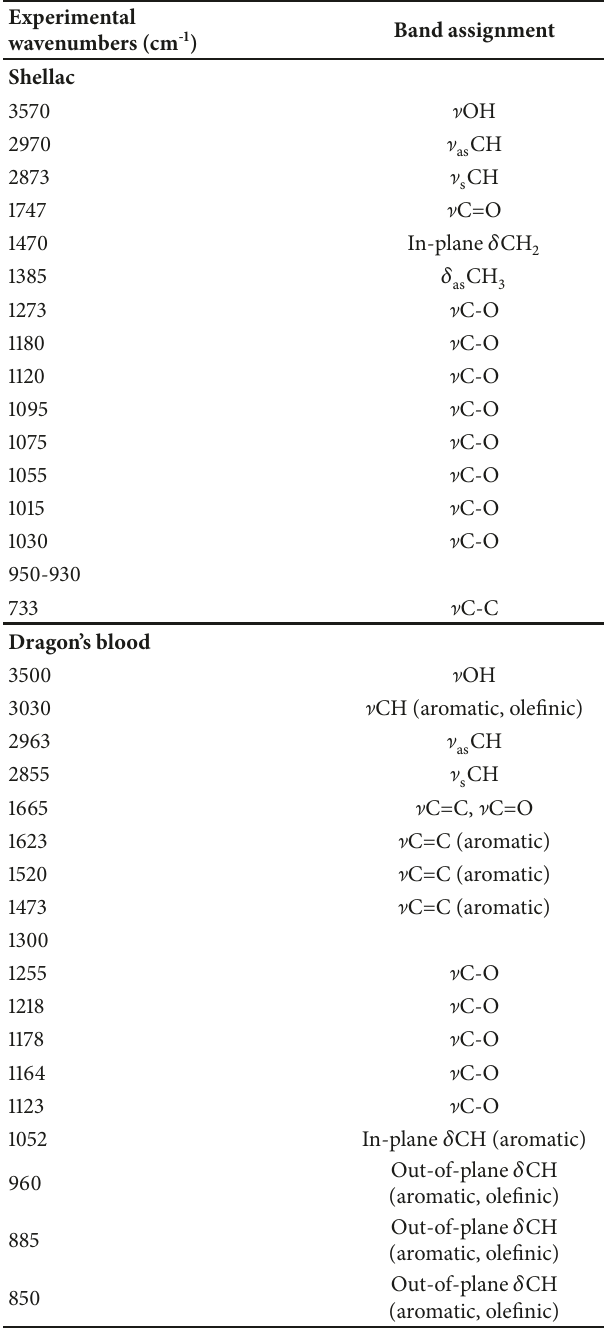
Table 7: Experimental wavenumber values corresponding to the maxima of the mid-IR total reflection mode bands of not (exclu- sively) terpenoid-based resins and their tentative